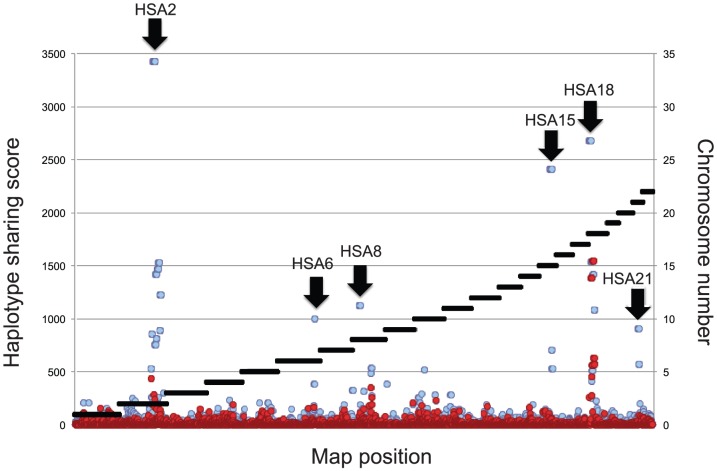
Haplotype sharing score across the genome.The limits between the 22 autosomes are indicated by the black horizontal bars (right Y-axis). The scores (left Y-axis) obtained when imposing haplotype sharing for the nine/nine cases plus the obligate carrier are given by the red circles. The scores obtained when imposing haplotype sharing for eight/nine cases plus the obligate carrier are given by the blue circles. The six identified chromosome segments are marked by the black arrows.